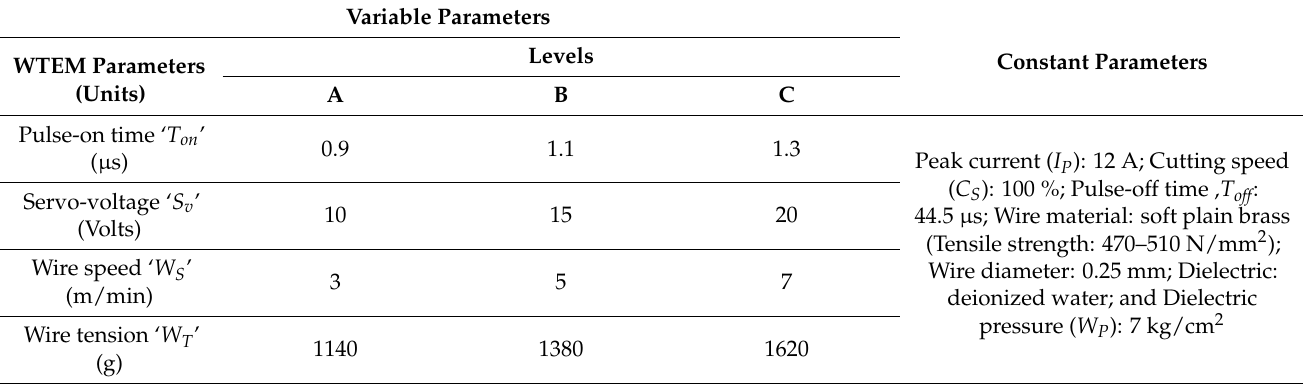
Table 1. Values of the constant parameters, levels, and corresponding values of the variable parameters of WTEM used in the